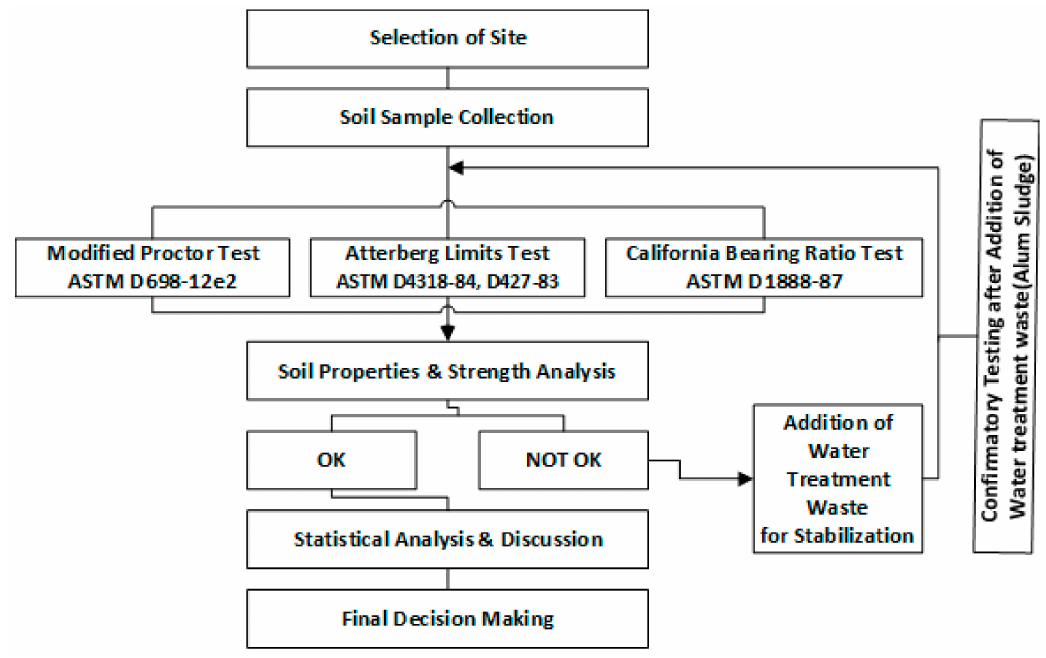
Figure 1. A research framework for the experimental